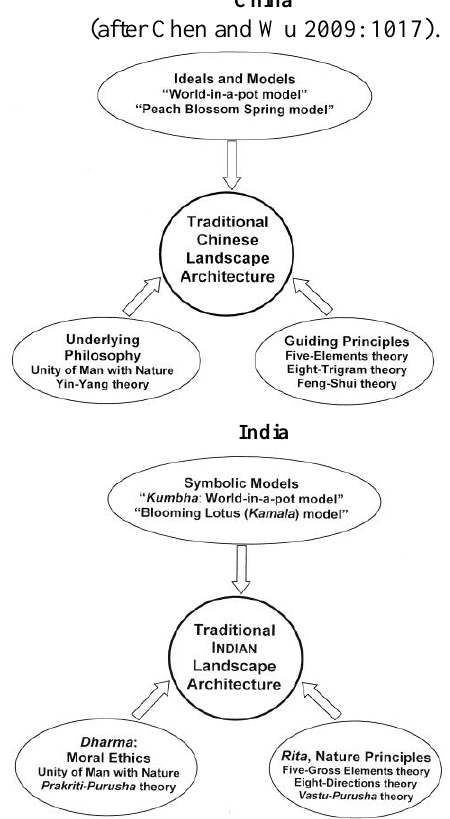
landscapes refer to breath of life ( prana in India, ki in Korea, ch’i in China), and closely related to wind and water. Fig. 1. China and India: Philosophical and cultural foundations of the landscape architecture China (after Chen and Wu 2009: